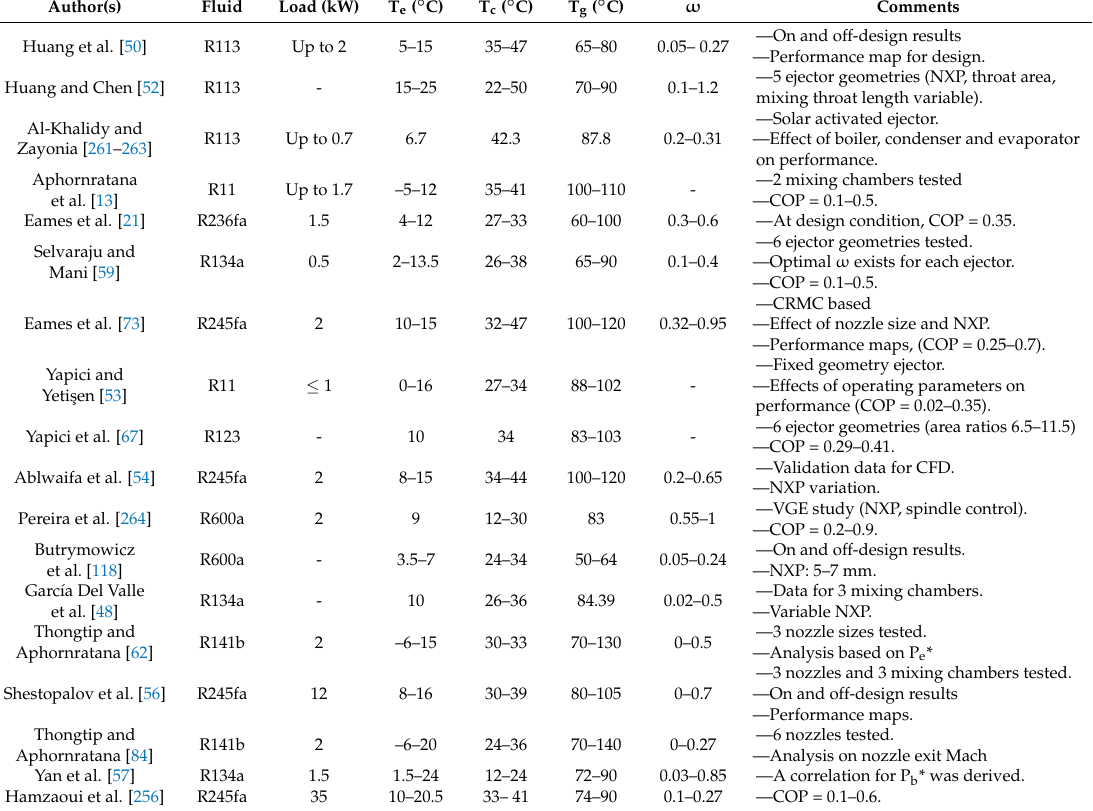
Table 5. Experiments with organic